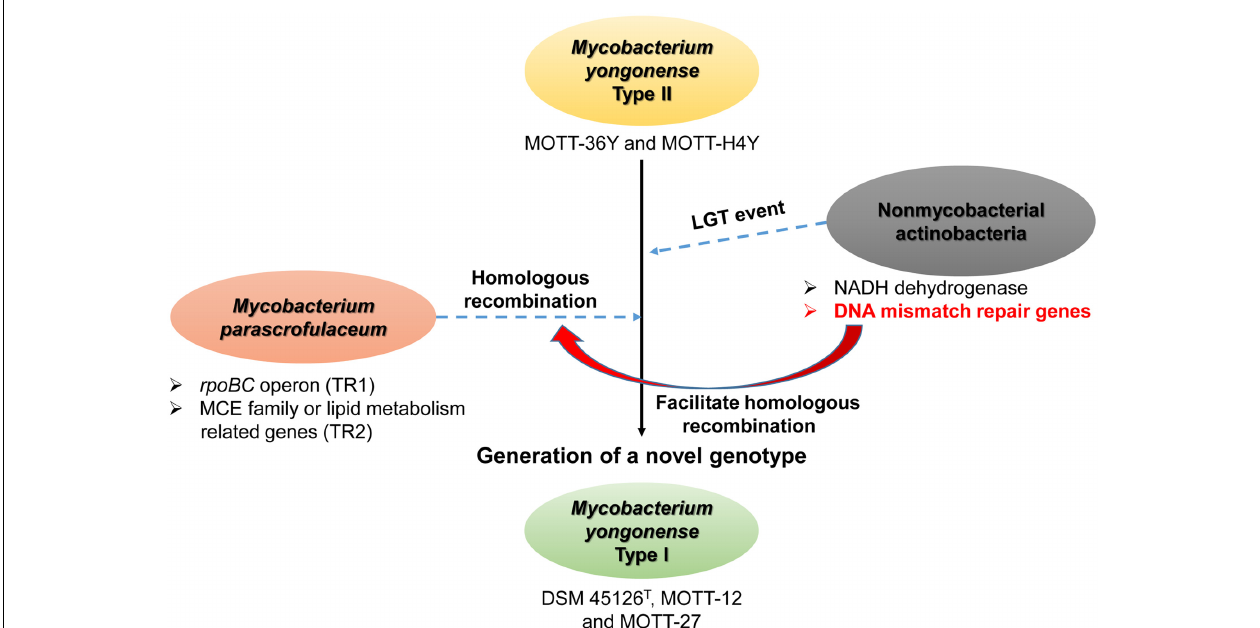
FIGURE 6 | Schematic representation showing role of MutS4 gene in evolution of M. yongonense Type I via homologous recombination event of TR1 and TR2 from M. parascrofulaceum to M. yongonense Type